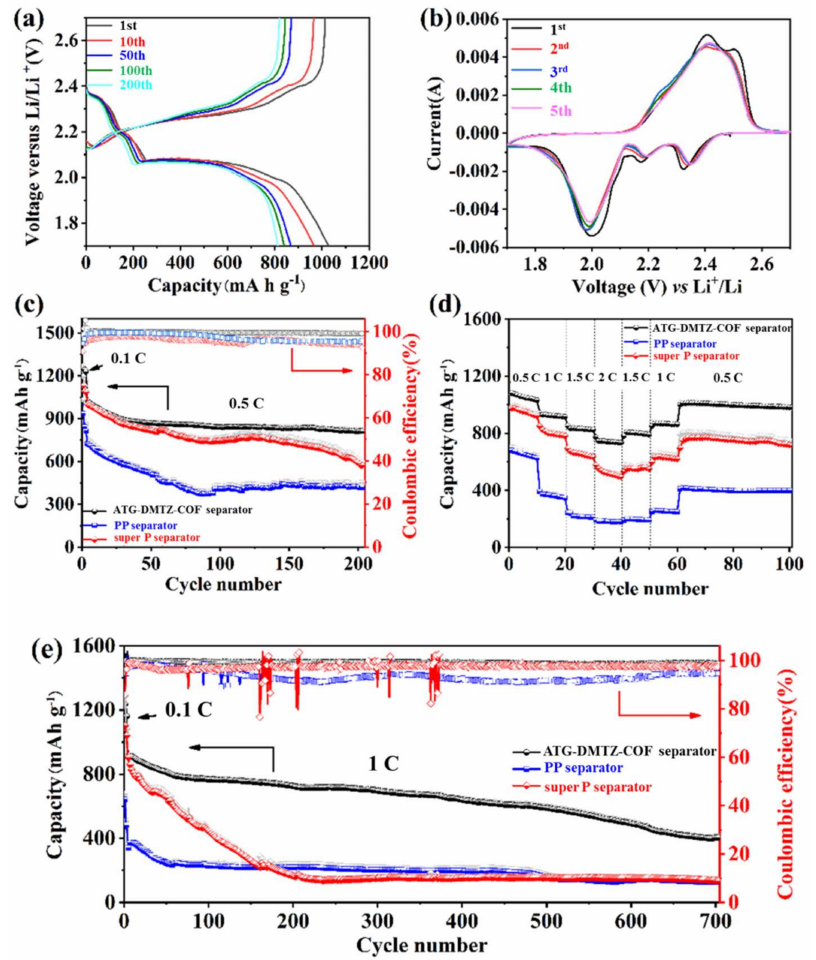
Figure 4. ( a ) The galvanostatic charge-discharge curve of ATG-DMTZ-COF/PP separator at a current density of 0.5 C. ( b ) CV curve of ATG-DMTZ-COF/PP separator at a sweep speed of 0.1 mV s − 1 . ( c ) The electrochemical cycling performance of three kinds of separator at a current density of 0.5 C. ( d ) The rate performance of Li-SeS 2 batteries with different separator. ( e ) The long cycle performance of different separator at a current density of 1